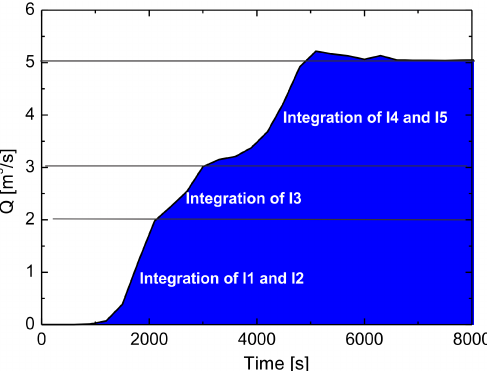
Figure 12. The time evolution of total discharge from the network in Fig.